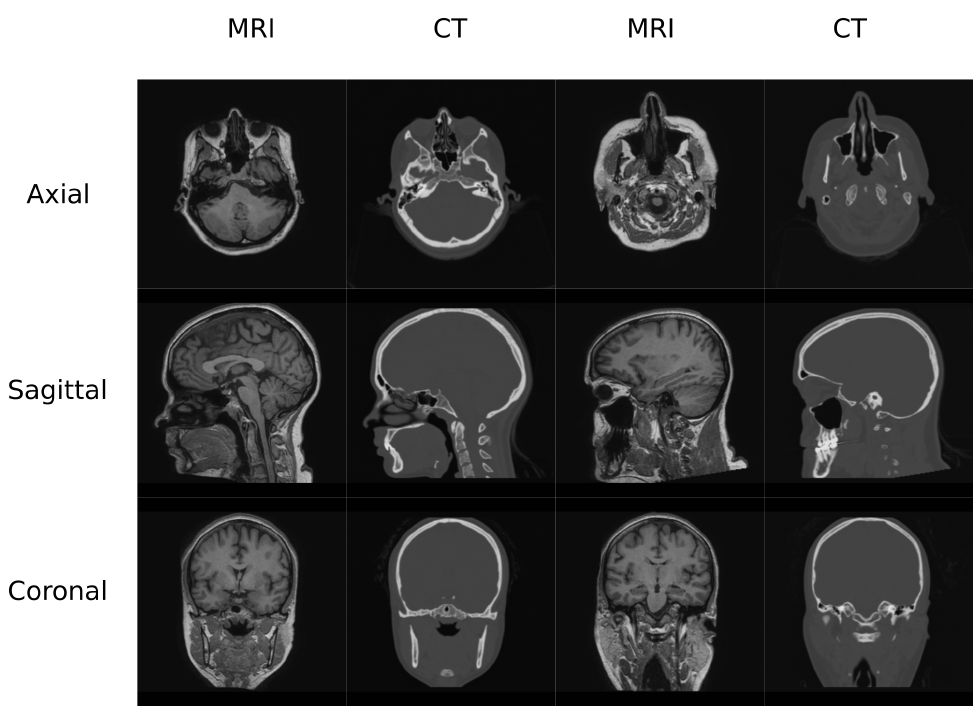
Figure 1. Head Data set